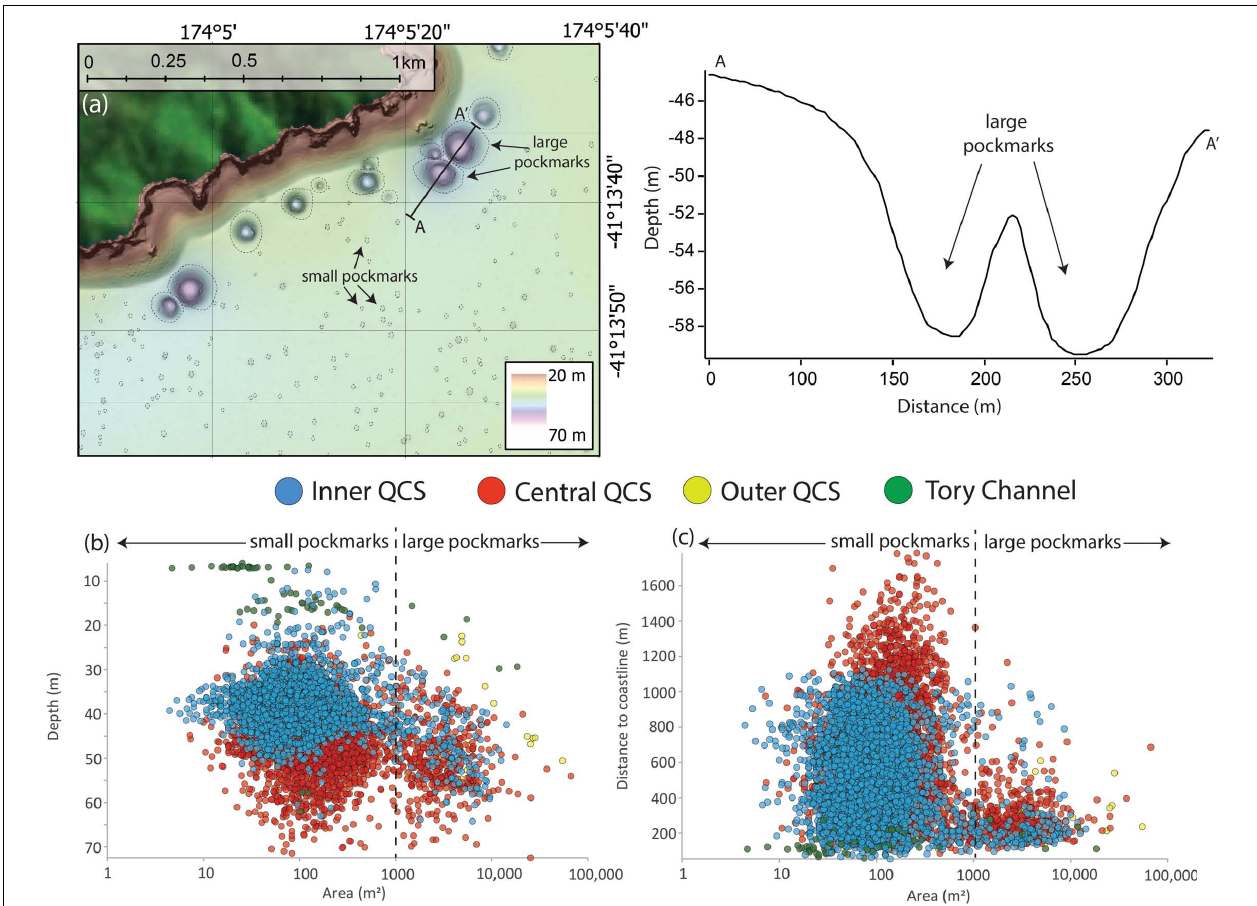
FIGURE 3 | (a) Zoomed in view of small and large pockmark seafloor morphology in the inner QCS, dashed black lines highlight the locations of pockmarks. Location of profile A-A’ is shown, traversing two large pockmarks. (b) Plot showing the pockmark area vs. water depth and (c) pockmark area vs. distance to nearest coastline, for all pockmarks in the QCS and TC. Colors represent the four main regions: inner QCS (blue), central QCS (red), outer QCS (yellow) and TC (green). Dashed lines show the distinction between small ( < 1000 m 2 ) and large ( > 1000 m 2 )